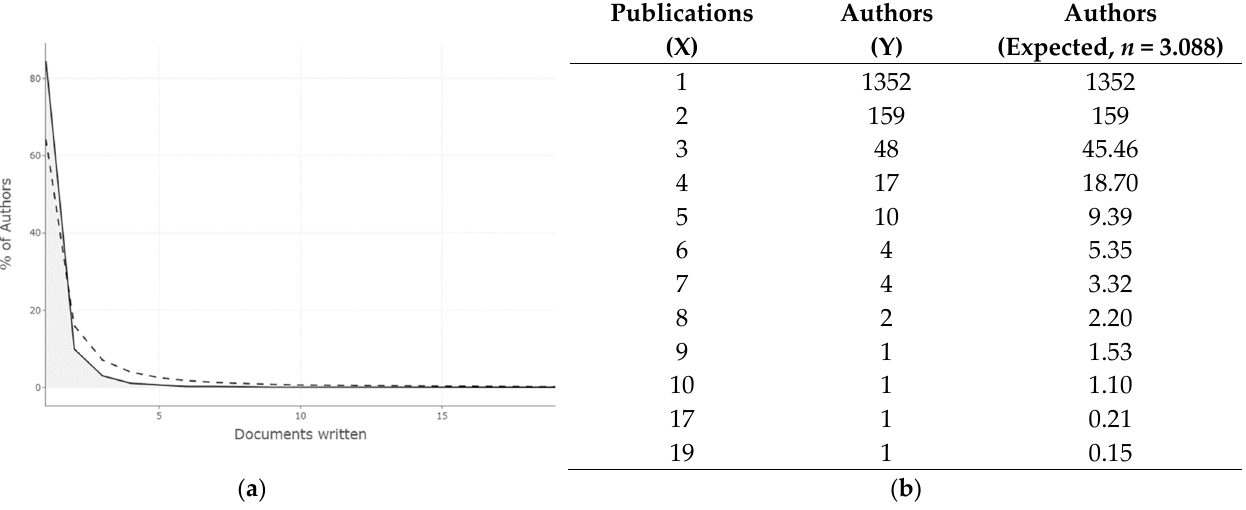
Figure 3. Source clustering through Bradford’s Law.